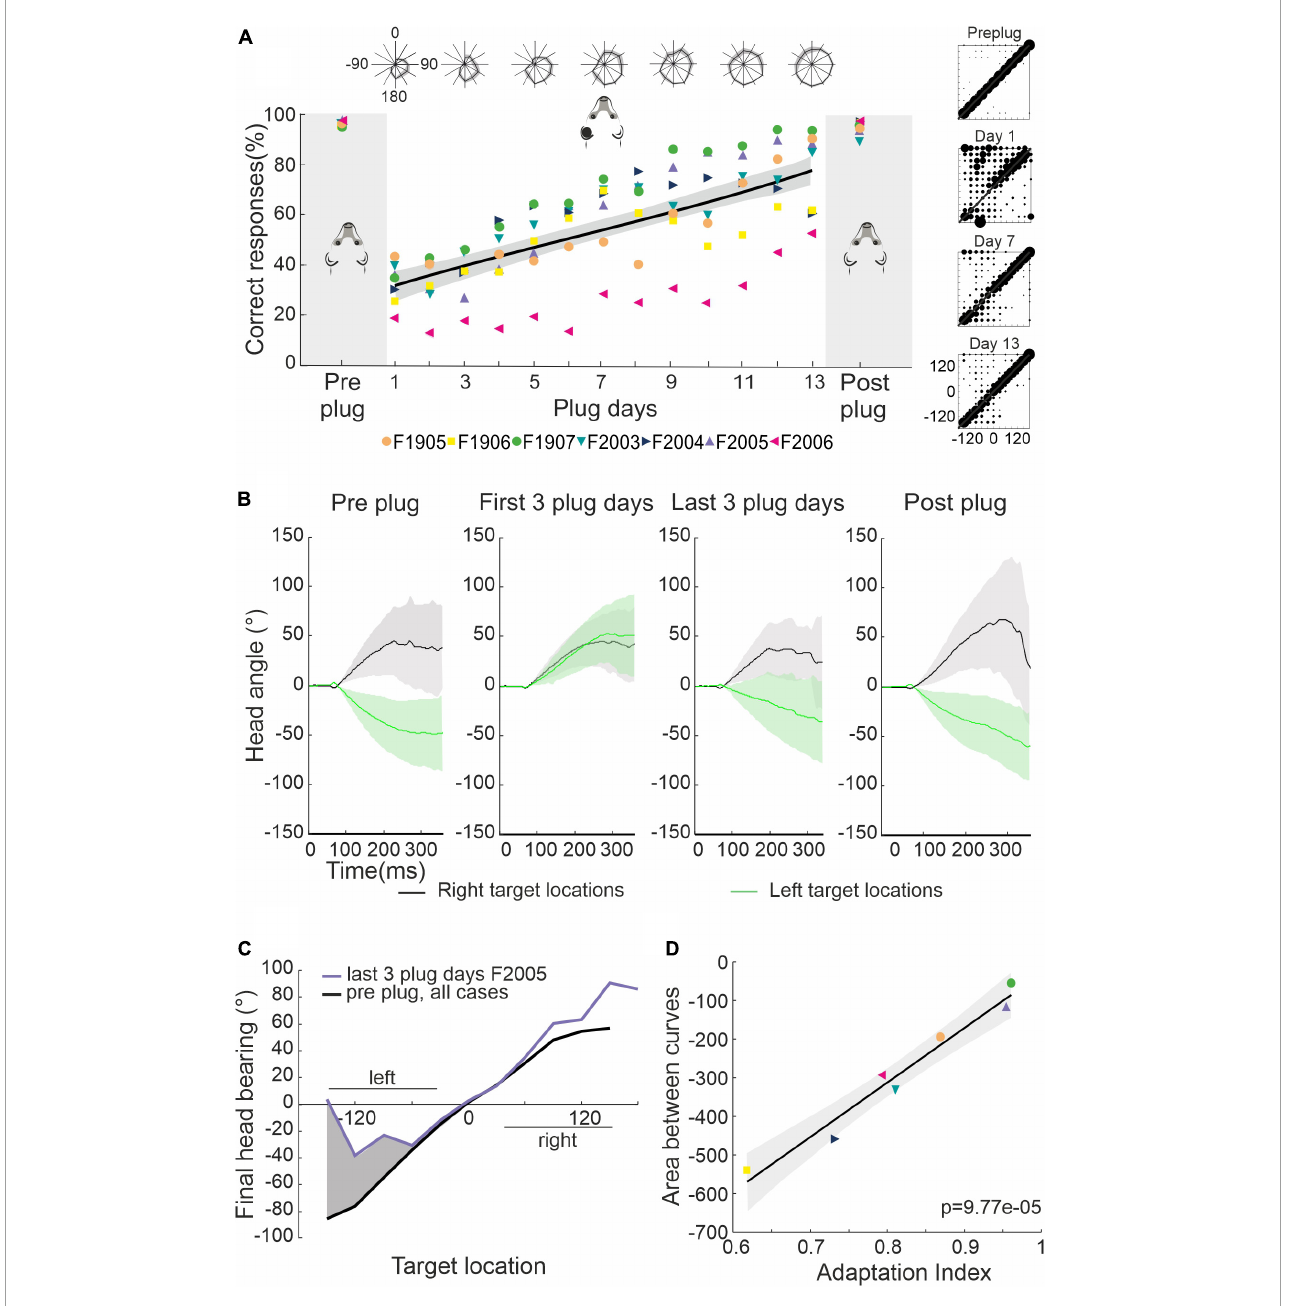
FIGURE2 Adaptive changes in approach-to-target and head orienting responses over the course of monaural occlusion. (A) Percentage correct scores for the approach-to-target behavior. Different symbols indicate individual ferrets. Their mean scores over 3 days prior to earplug insertion and 3 days after earplug removal are highlighted by the gray regions on either side of the scores obtained for each day of training with the left ear occluded, which for these animals lasted 13–16 days (days 1–13 only are shown). The black line and shaded area represent the linear regression and the 95% confident intervals for the data obtained with the earplug in place. The polar plots at the top show the mean ± S.E. score across animals at different target locations for every 2 days of training. The stimulus-response plots on the right show the distribution of response locations selected ( y -axis) as a function of target location ( x -axis) before and at three different time points after earplug insertion. (B) Mean ± S.E. changes in head angle for left (green) and right (black) target locations for ferret F2005 (measured at 500 FPS and low-pass filtered at 50 Hz for plotting). Positive values correspond to rightward turns and negative values correspond to leftward turns of the head. Plots from left to right correspond to the 3 days before earplug insertion, the first 3 days with the ear plugged, the last 3 days with the ear plugged, and the 3 days following earplug removal. Occluding the left ear disrupted head orienting responses made to locations on the left, which progressively recovered as approach-to-target performance improved with training. (C) Mean final head bearing versus target location before earplug insertion averaged across all animals (black) and for the last 3 days of earplug adaptation for the example animal F2005 (purple). The shaded region represents the area between the two curves on the side of the occluded ear, computed as an index of adaptation of the head orienting responses. (D) Relationship between the adaptation index (ratio of the percentage correct scores on the last 3 days of plugging and before earplug insertion), which reflects recovery with training of the approach-to-target behavior, and adaptation of the head orienting responses (the area between the head orientation curves, as in panel C ) for all seven animals shown in panel (A)